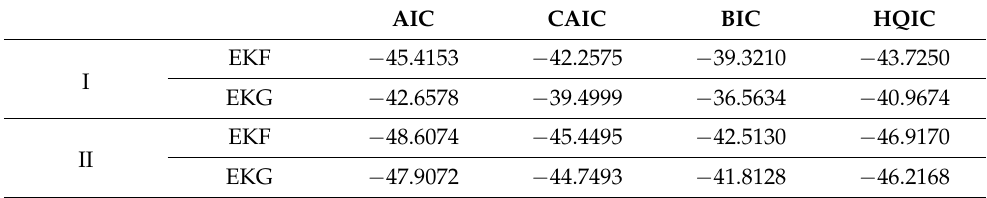
Table 6. Goodness-of-fit measures, AIC, BIC, CAIC, and HQIC for the hole diameter